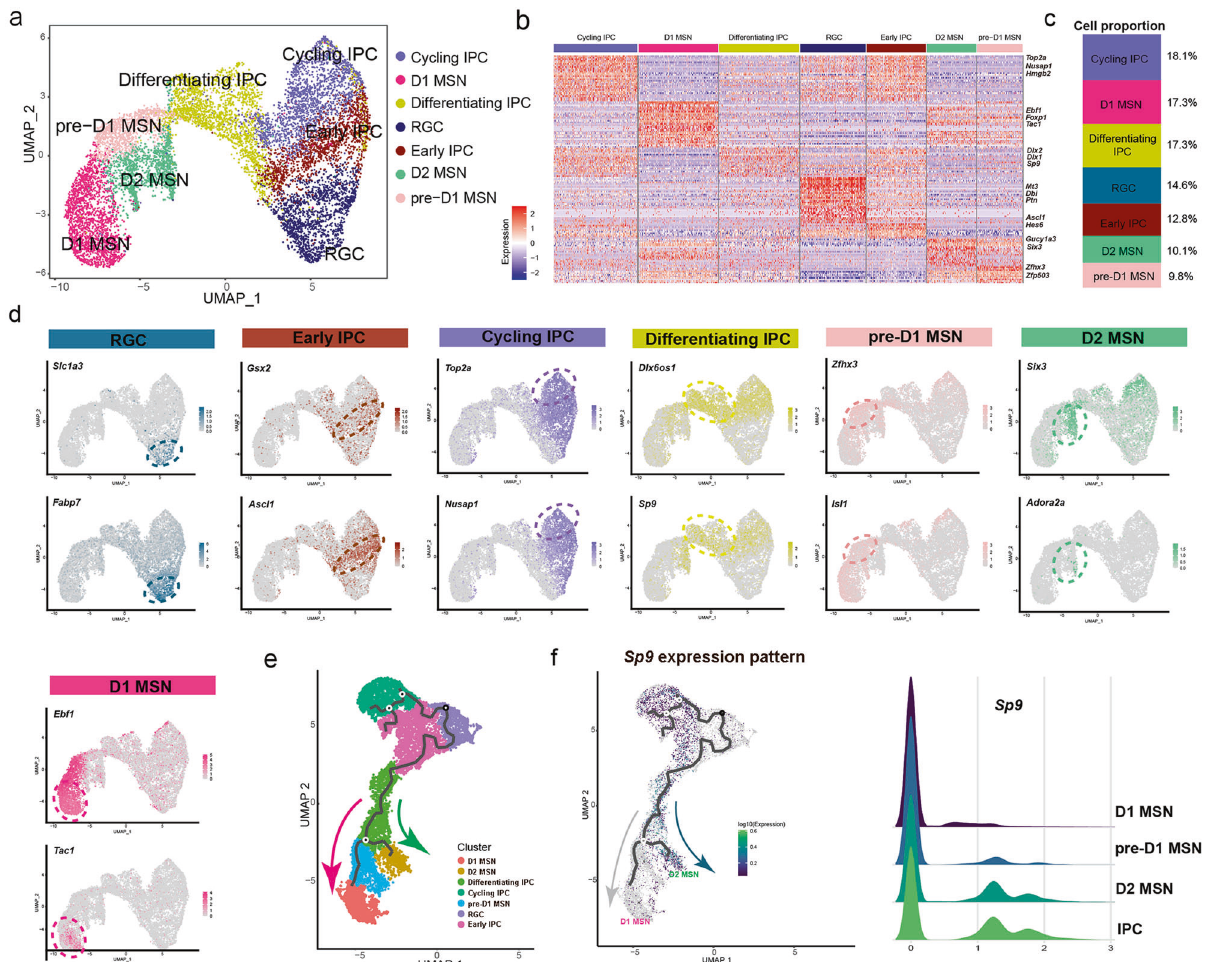
Fig. 2 Identi fi cation of the developmental hierarchy of LGE cells. a The UMAP plot of LGE cells. b The heatmap of the LGE cells ordered by the UMAP showed in a . Each column represents expression in one cell, and each row represents expression of one gene. c The proportions of distinct clusters among total LGE cells. d UMAP plots of the expression levels of selected marker genes in the seven subpopulations. e Monocle3 revealed predicted lineage trajectories from RGC in the LGE; each point represents a cell and is colored on the basis of cluster identity. f Sp9 expression pattern in the predicted lineage trajectories, and ridge plots shows Sp9 expression distribution in the MSN Progenitor, pre-D1 MSN, D1 MSN, and D2